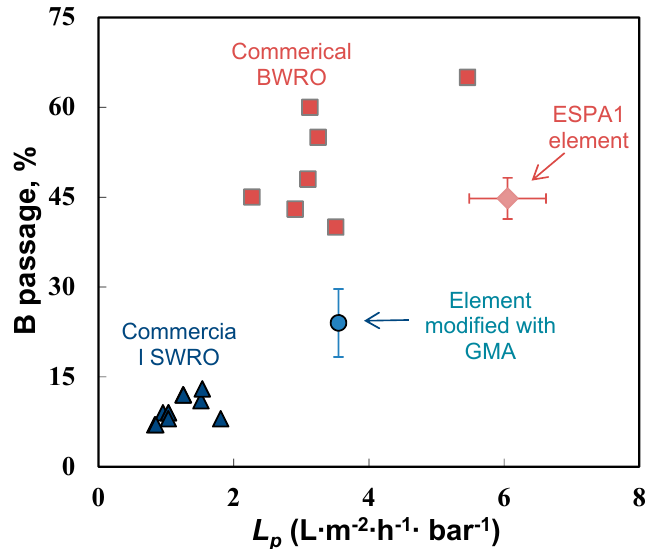
Figure 7. Permeability and boric acid passage of commercial seawater (triangles) and brackish water (squares) reverse osmosis elements, pristine ESPA1 element (diamond), and modified ESPA1 element (circle). Modification conditions: 2 mM GMA with addition of 0.045 mM Triton, modification time 0.5 h.